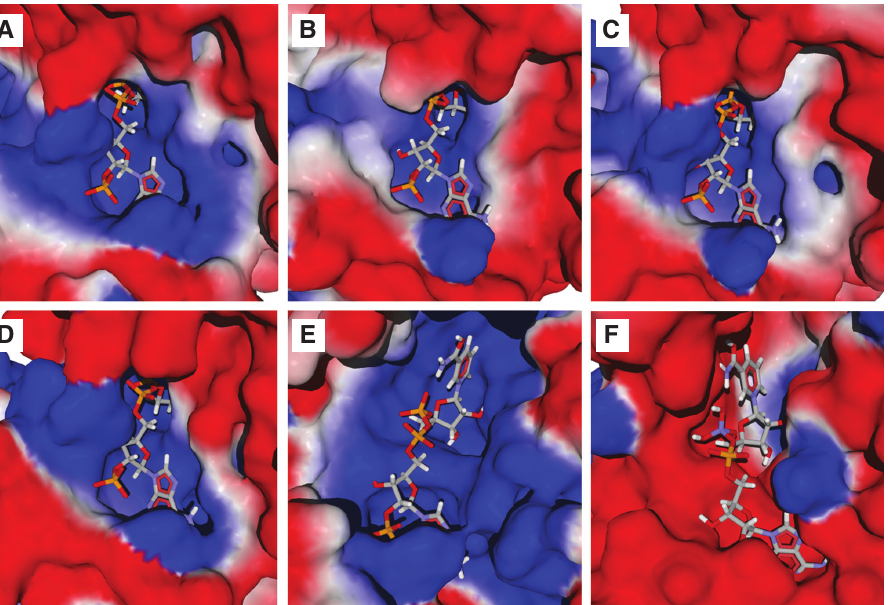
Figure 3: Potential electrostatic surfaces of NADP(H)-binding sites. The structures shown are from (A) mouse, (B) rat, (C) human, (D) zebrafish, (E) fly CG12117, and (F) fly CG12116. NADP + is shown as a stick model, with the carbon, oxygen, nitrogen, and phosphate atoms indicated in gray, red, blue, and orange,